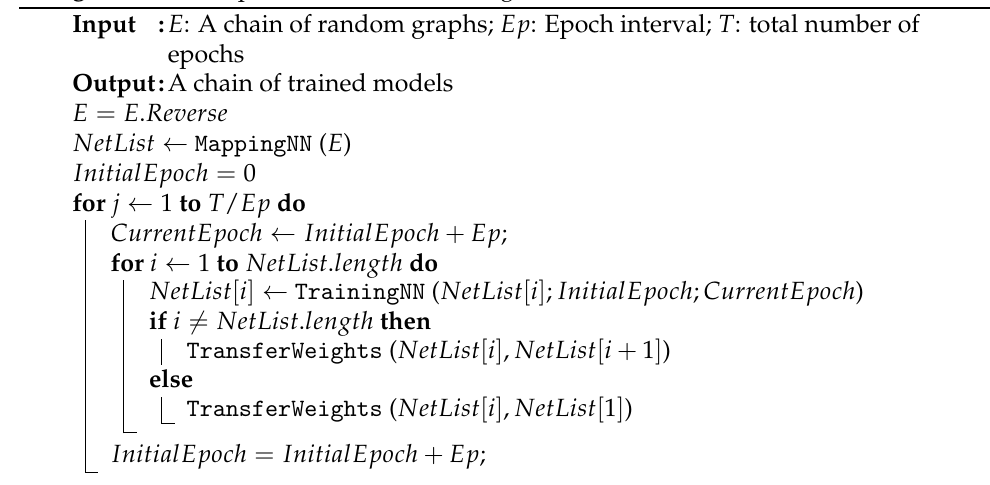
Algorithm 2: Deep Collaborative